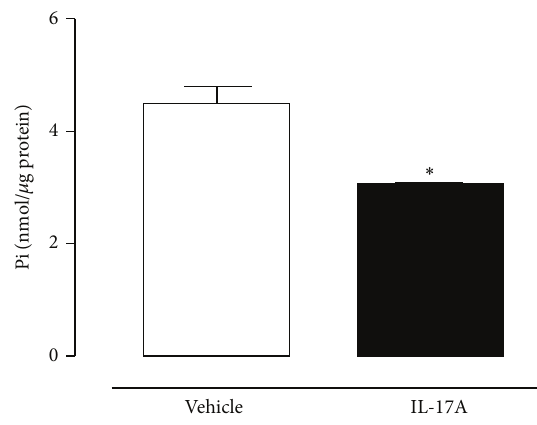
Figure 4: Quantification of inorganic phosphates (Pi) produced by rat carotid homogenates treated with vehicle or IL-17A. Pi produced was evaluated as measure of ADP hydrolyzing activity (for details, see method section). ∗ 𝑃 < 0.05 versus vehicle (Student’s t -test; 𝑛 = 3